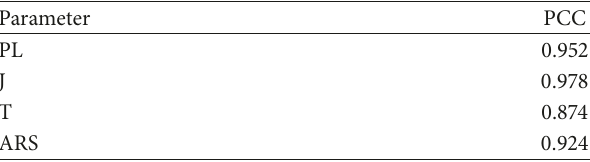
Figure10:RelationshipbetweenautoresolutionscalingandQoE (from subjective test).